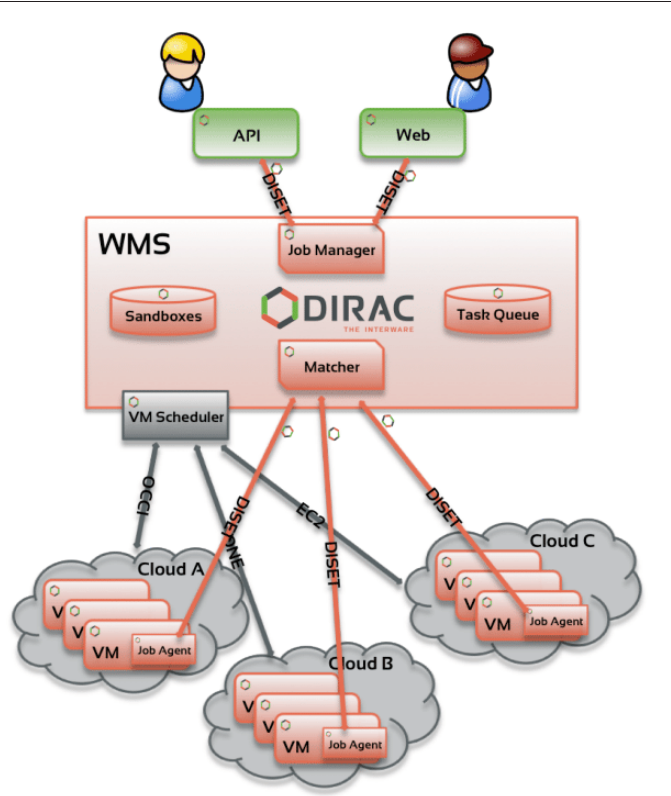
Figure 2: The DIRAC Interware software framework [3]. It is an open source solution to the task of managing distributed computing resources via a grid based cloud storage. It